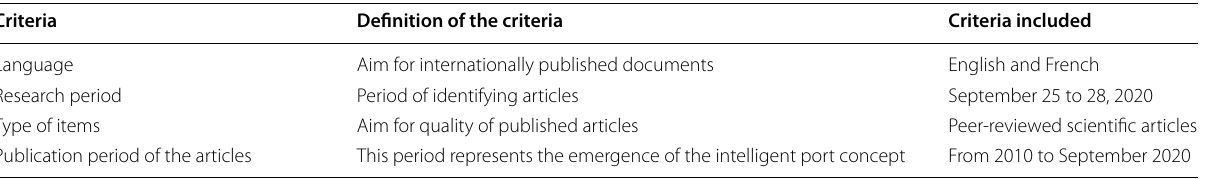
Table 1 Inclusion criteria of the reviewed articles Criteria